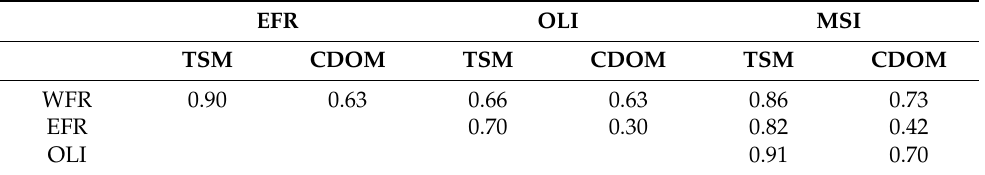
Table 6. Coefficients of determination ( R 2 ) of the retrieved TSM and CDOM parameters in the coastal water ( n = 275).